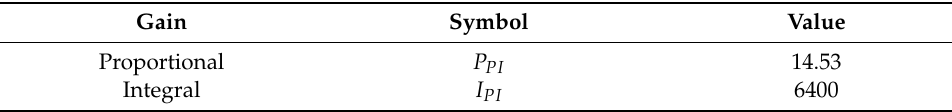
Table 2. Current controller gains.